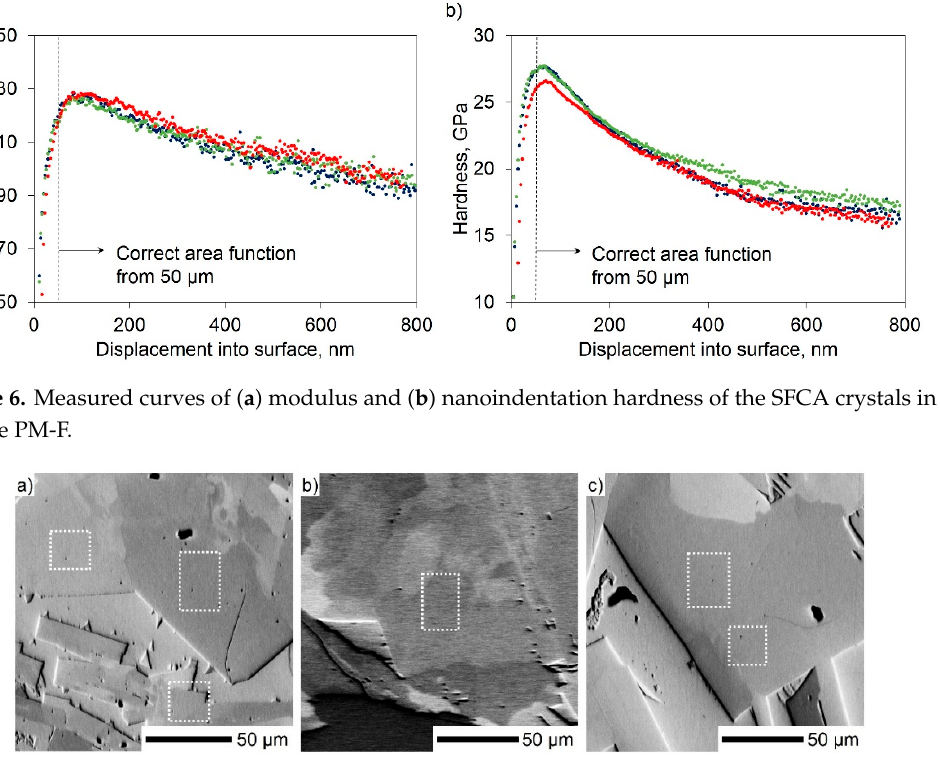
Figure 7. Forescattered electron orientation contrast images of the domains where nanoindentation was applied: ( a ) PM-F, ( b ) PM-A, and ( c ) PM-S. Squares and rectangles mark the position of 9 and 12 indents, respectively.